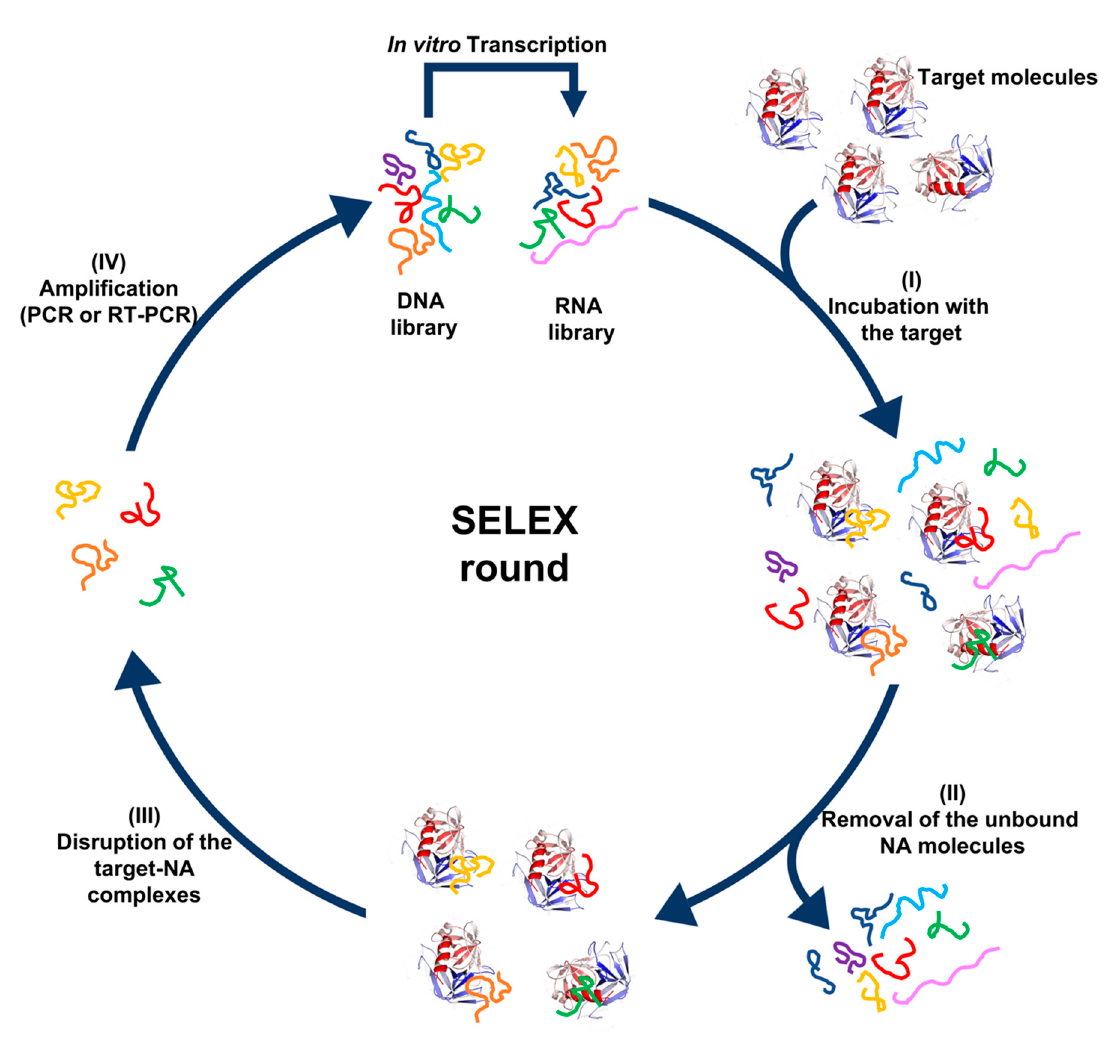
Figure 2. Schematic diagram of the SELEX method using DNA and RNA libraries.